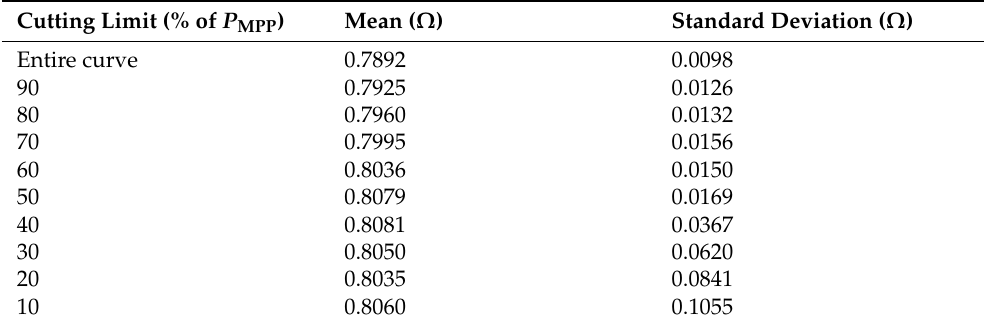
Table 2. Statistical quantities of the fitted series resistance values for different cutting limits based on MPP power during the 40 min measurement period.